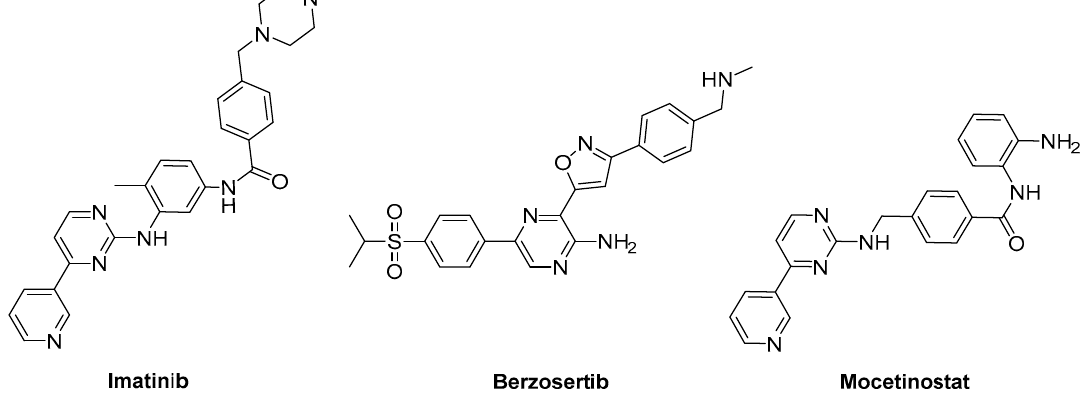
Figure 2. Structures of imatinib, mocetinostat, and berzosertib.